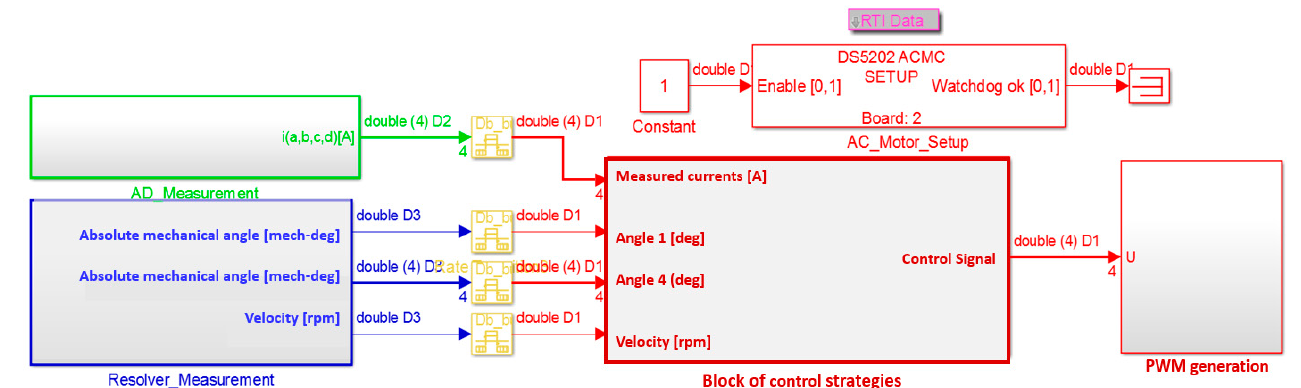
Figure 12. RTI block scheme of the implemented control strategies. 1—block of the four measured currents i a , i b , i c, and i d . 2—block of the measured position and velocity with a resolver mounted on the shaft of the SRM. 3—block of the control strategies with the designed robust controllers; PI, SMC, and STSM implemented separately. 4—block of PWM signal generation.